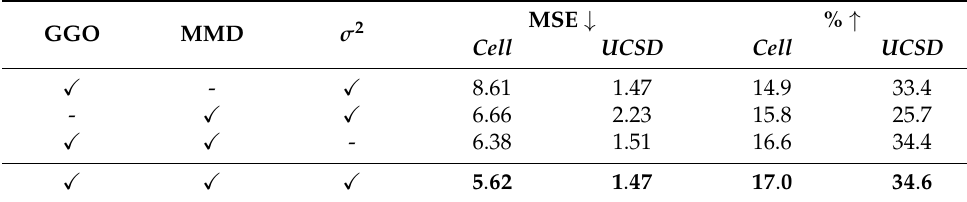
Table 5. Ablation study on cell and pedestrian datasets. GGO indicates the GAN Global Optimality Condition; MMD is the Maximum Mean Discrepancy; σ 2 is the variance-based regulariser.